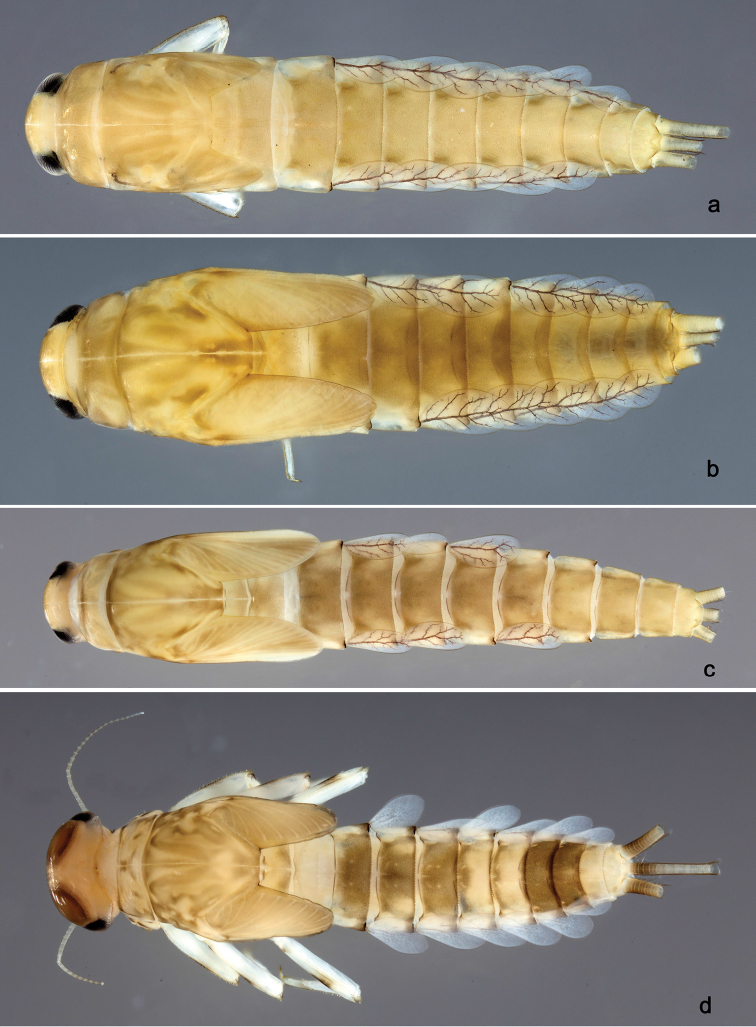
Habitus, larvae: aLabiobaetisbalkei sp. n., dorsal view bLabiobaetislobatus sp. n., dorsal view cLabiobaetismichaeli sp. n., dorsal view dLabiobaetisclaudiae sp. n., dorsal view.